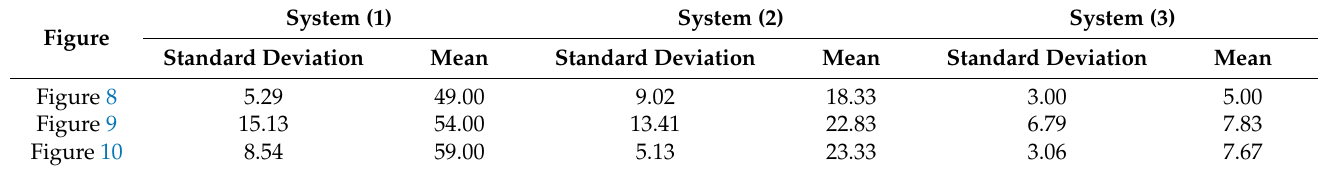
Table 2. Statistical analysis of simulation results of the three systems introduced in Figures 8–10.